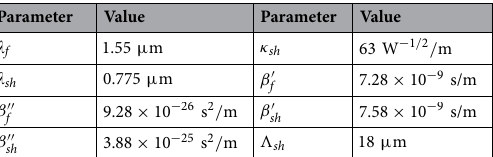
Parameter Value Parameter Value (cid:31)